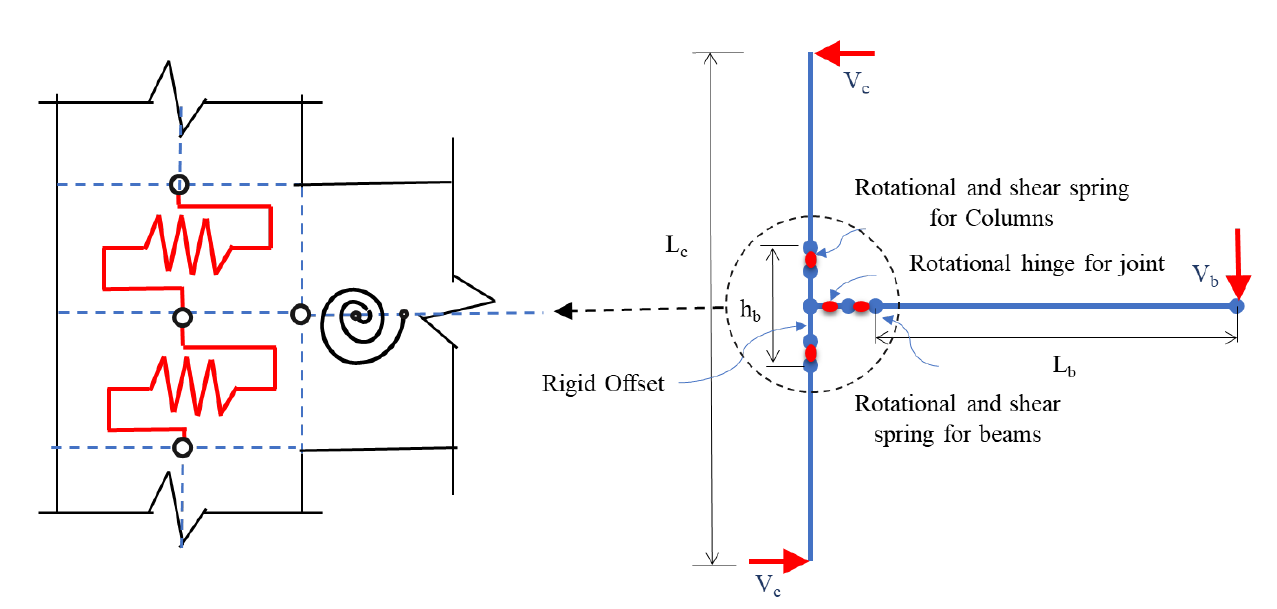
Figure 12. Multi-spring joint modeling philosophy and incorporation of joint and interface shear mechanism, reproduced from literature [73].